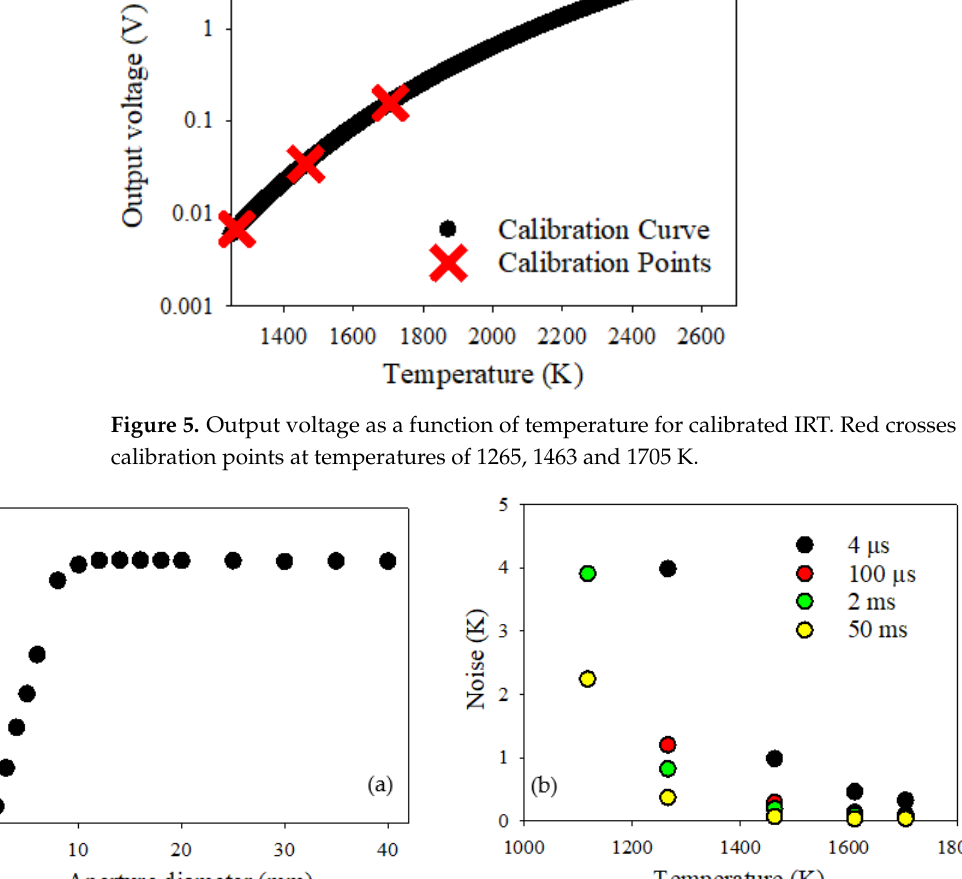
Figure 5. Output voltage as a function of temperature for calibrated IRT. Red crosses represent the calibration points at temperatures of 1265, 1463 and 1705 K.